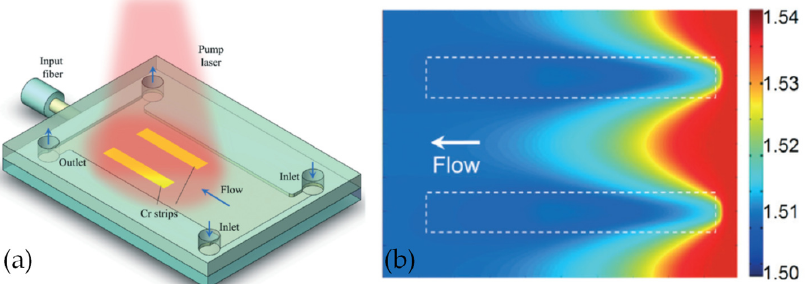
Figure 30. Laser-induced thermal gradient. ( a ) Schematic diagram of the thermal lens, and ( b ) the simulated two-dimensional refractive index profiles [136]. Reprinted with permission from Ref. [136]. 2016 Royal Society of Chemistry.